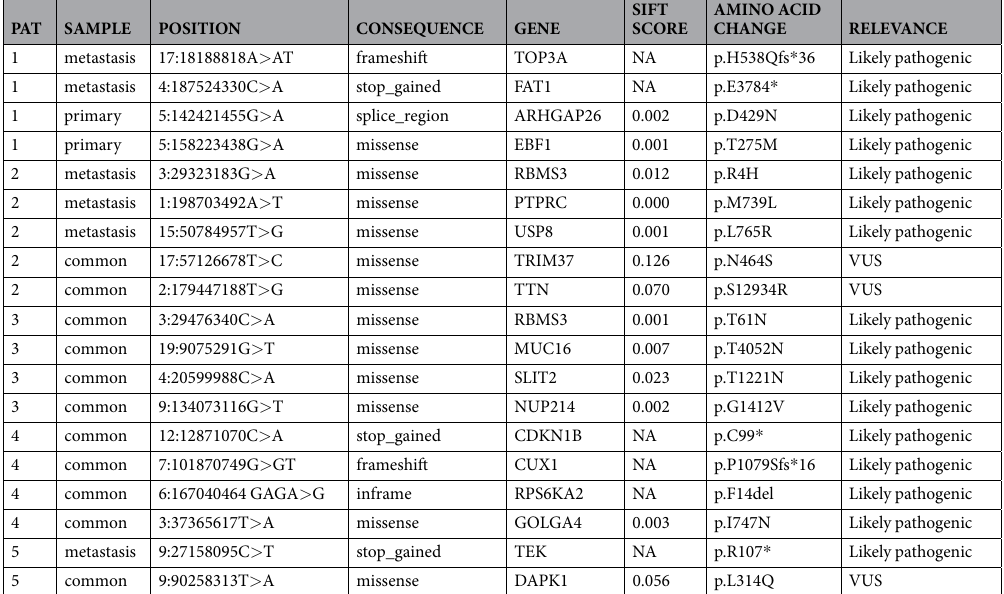
Table 2. Potential driver genes. Identified potential driver mutations within the study cohort. Genes found to be mutated within this study present as well in the cancer gene census or previous studies on small intestine neuroendocrine tumors were analyzed for potential pathogenicity (see methods for details). Mutations with a SIFT score ≤ 0.05 as well as nonsense or frameshift mutations were categorized as likely pathogenic, whereas the rest was classified as variants of unknown significance (VUS). Pat: patient, NA: not available.